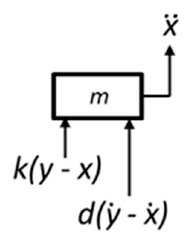
Figure 7. Free-body diagram of an individual system.